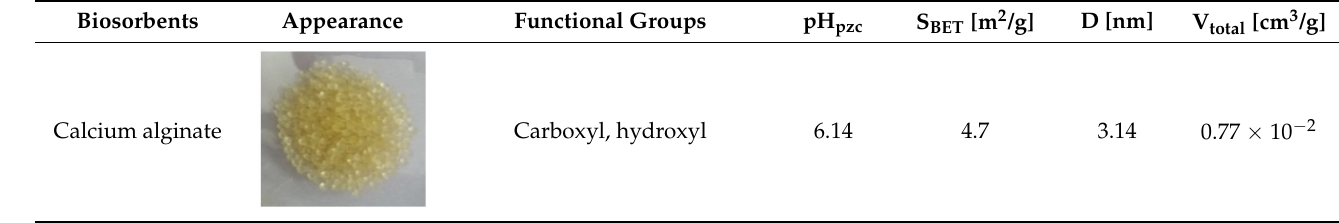
Table 1. Comparison of the ALG-based adsorbents